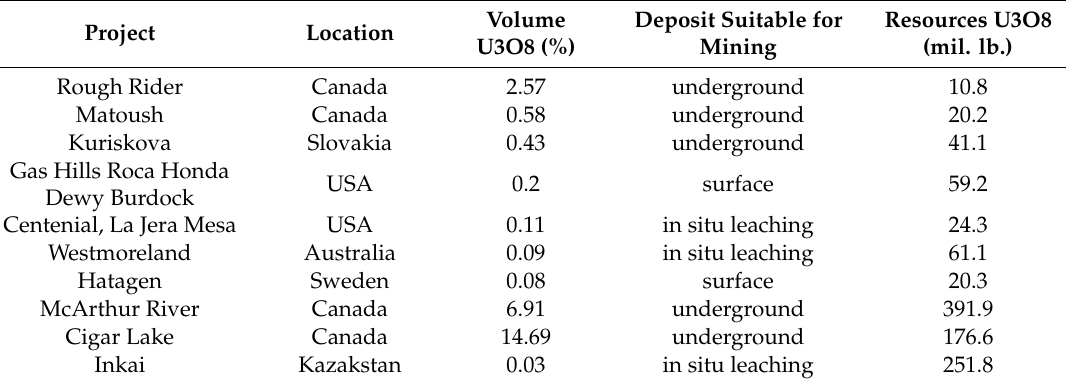
Table 1. The comparison of selected significant uranium deposits [59,60].